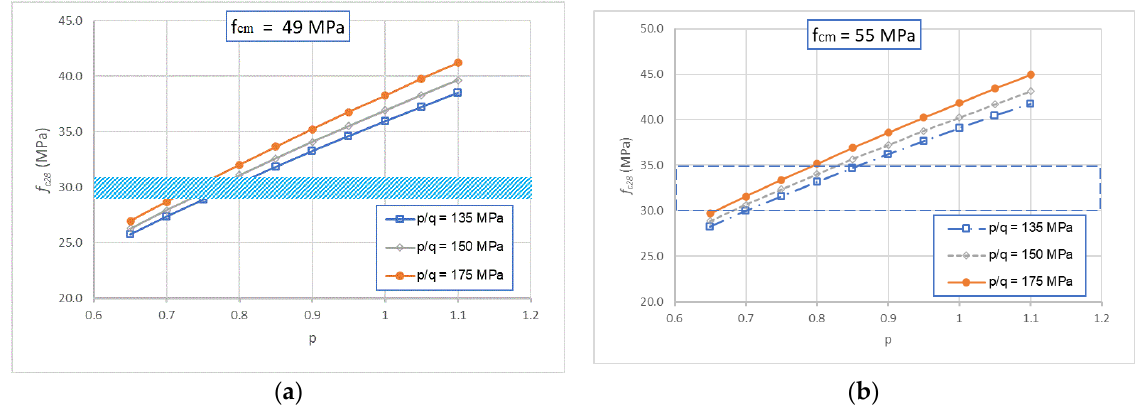
Figure 22. Numerical results of concrete compressive strength in function of p and p/q, for the case of ambient curing ( a ) and curing with heating treatment ( b ). The thick horizontal lines represent the experimental values.